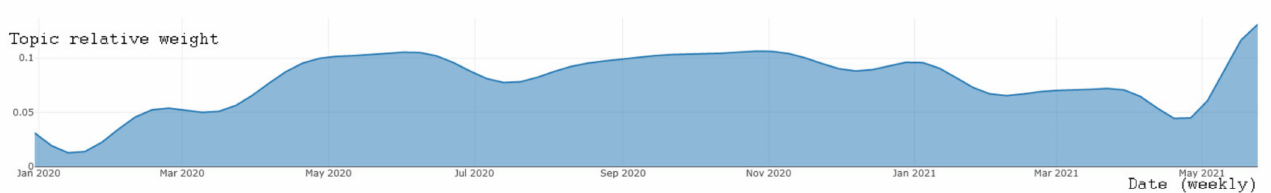
Figure 5. Weekly smoothed dynamics of “Case, Number, Day, Coronavirus, Reveal” topic relative weight.